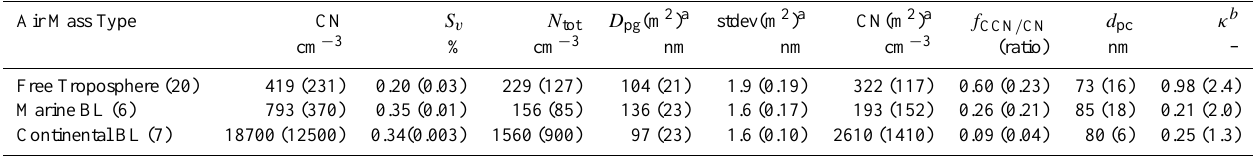
Table 3. Summary of measurements and calculated parameters for each air mass category. Values shown are arithmetic mean and standard deviation (in parentheses) of single values obtained for each leg within the designated air mass category unless otherwise indicated. All mass and number concentrations are reported for ambient temperature and pressure.